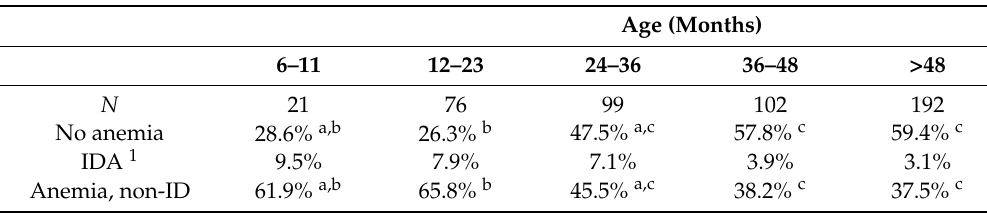
Table 6. Prevalence of anemia, iron deficiency and iron deficiency anemia by age group in Cambodian children.